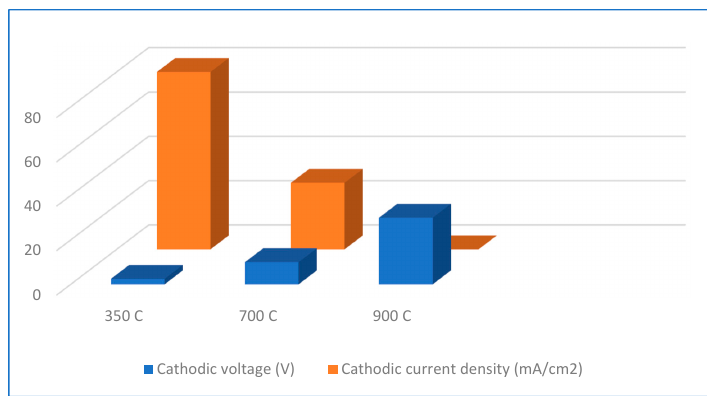
Figure 5. Voltage and current density values for specimens oxidized at different temperatures and subject to hydrogen charging.